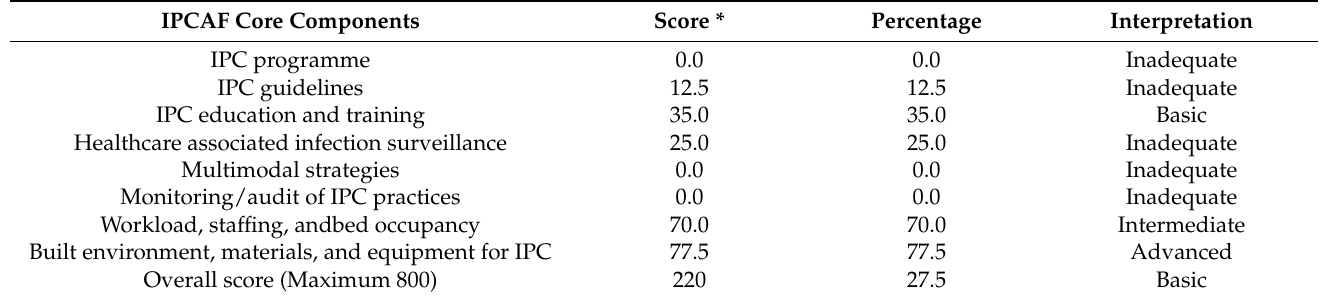
Table 2. Baseline IPC compliance level of Lira University Hospital (November